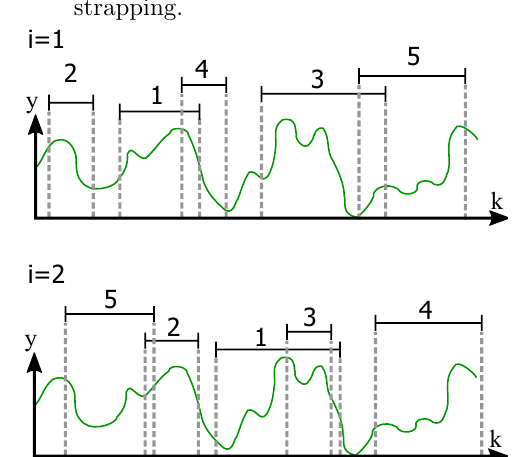
Figure 7: Illustrative example of two iterations of stationary bootstrapping, resulting in five blocks of data, possibly overlapping, with uniformly drawn starting point and geomet- ric length